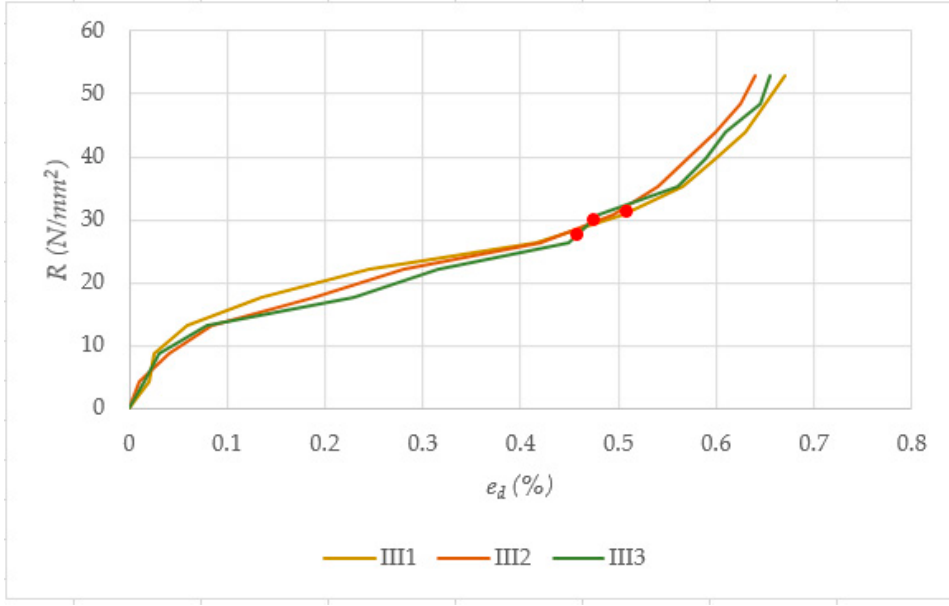
Figure 9. Stress–strain curves for samples reinforced with flat steel meshes.